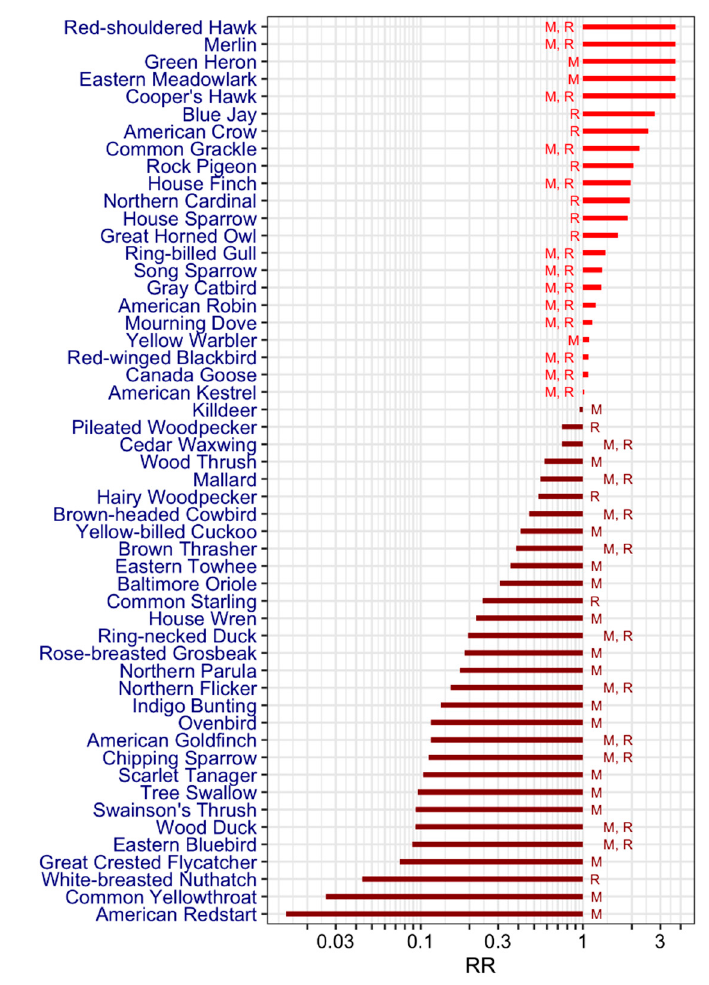
Figure 7. List L 3 : ranked list ( n = 53) of bird species found from the literature review. RR stands for relative risk or ratio of sero-positives. Quoted letters “M” and “R” stand for migratory and resident birds, respectively.